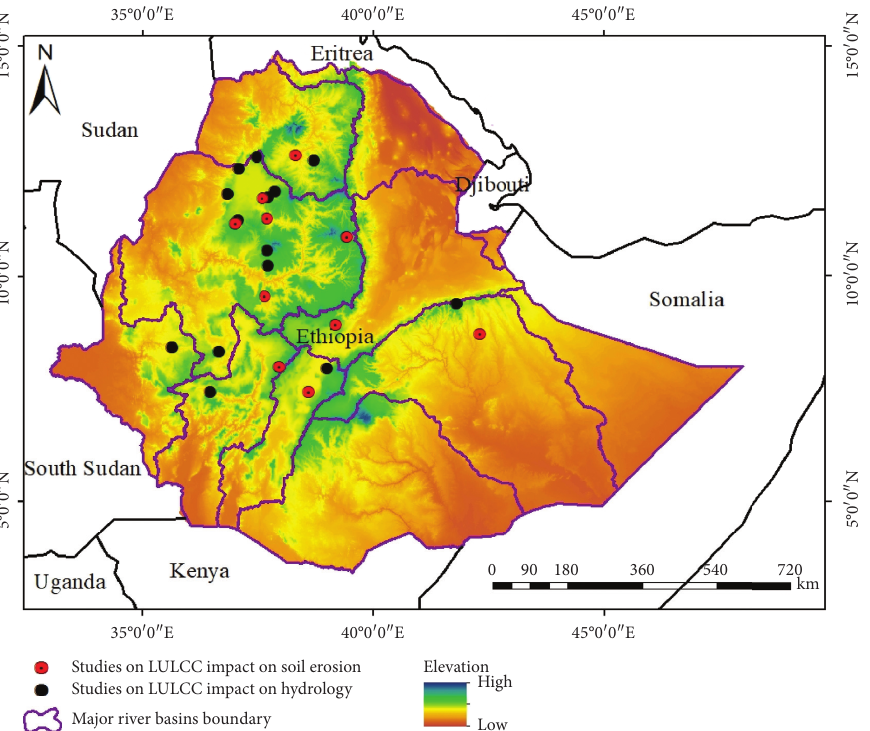
Figure 1: Study sites of the impact of LULC change on soil erosion and hydrological responses in Ethiopia. LULCC: land use and land cover change.